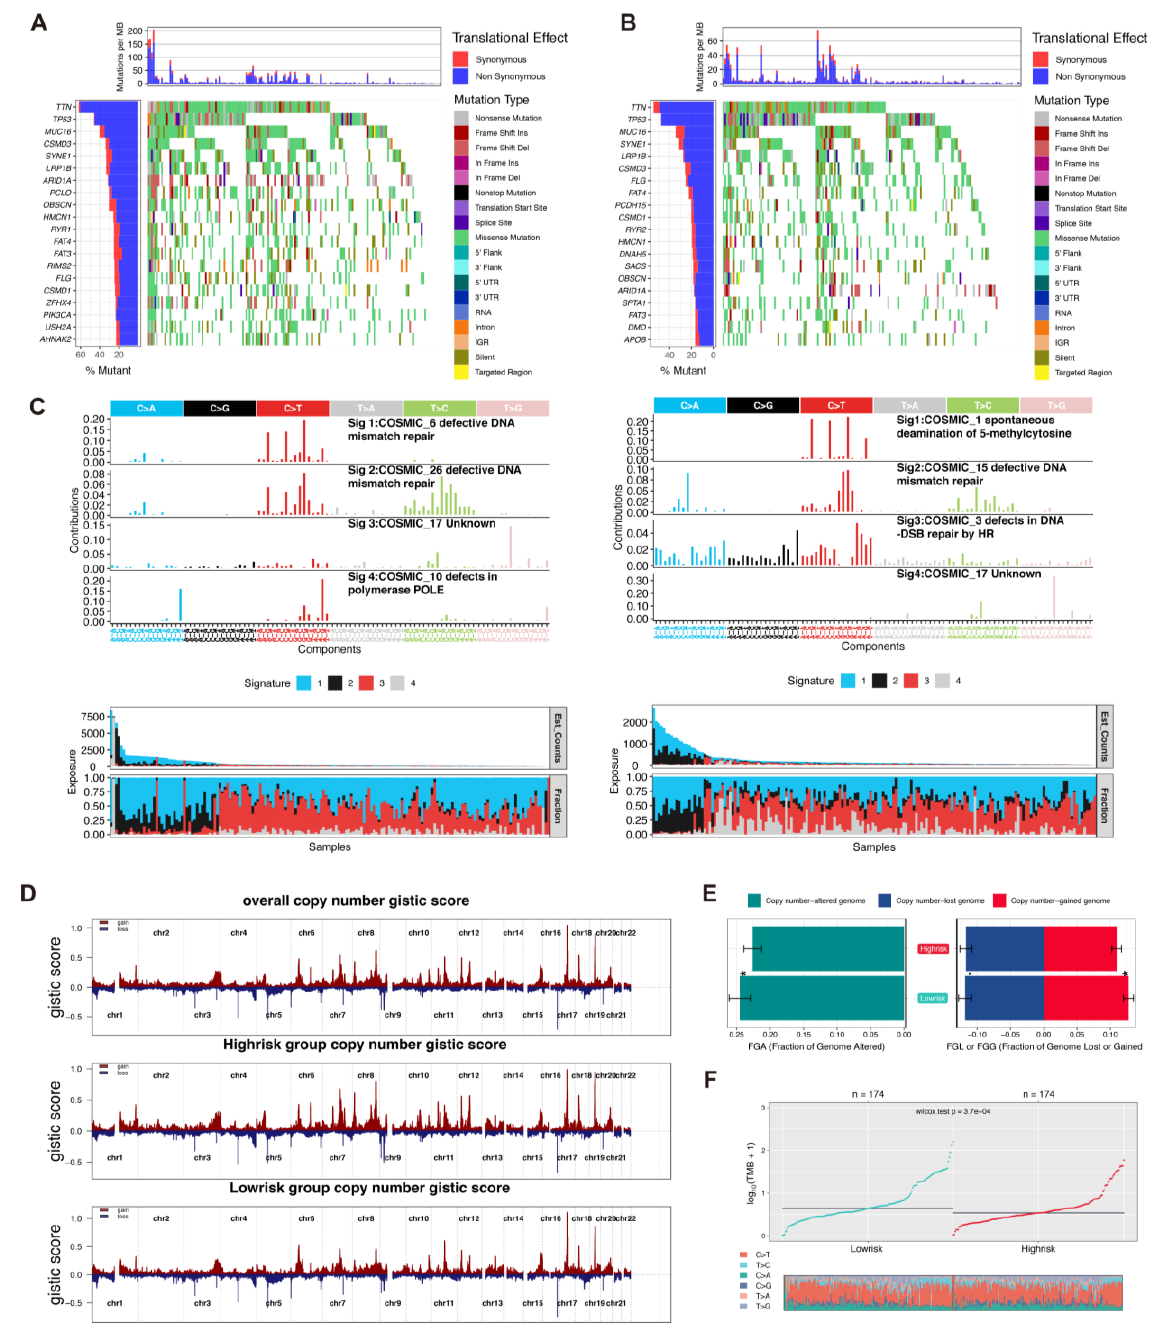
Figure 4. Genomic mutation patterns of two risk groups. ( A , B ). Somatic mutations of patients in low-risk and high-risk groups were displayed via waterfall plot. ( C ). The COSMIC SBS mutation signatures of two risk groups. ( D ). The genomic copy number variations of TCGA-STAD patients, analyzed by Gistic 2.0. ( E , F ). Comparison of TMB and fraction genome alteration between two groups.